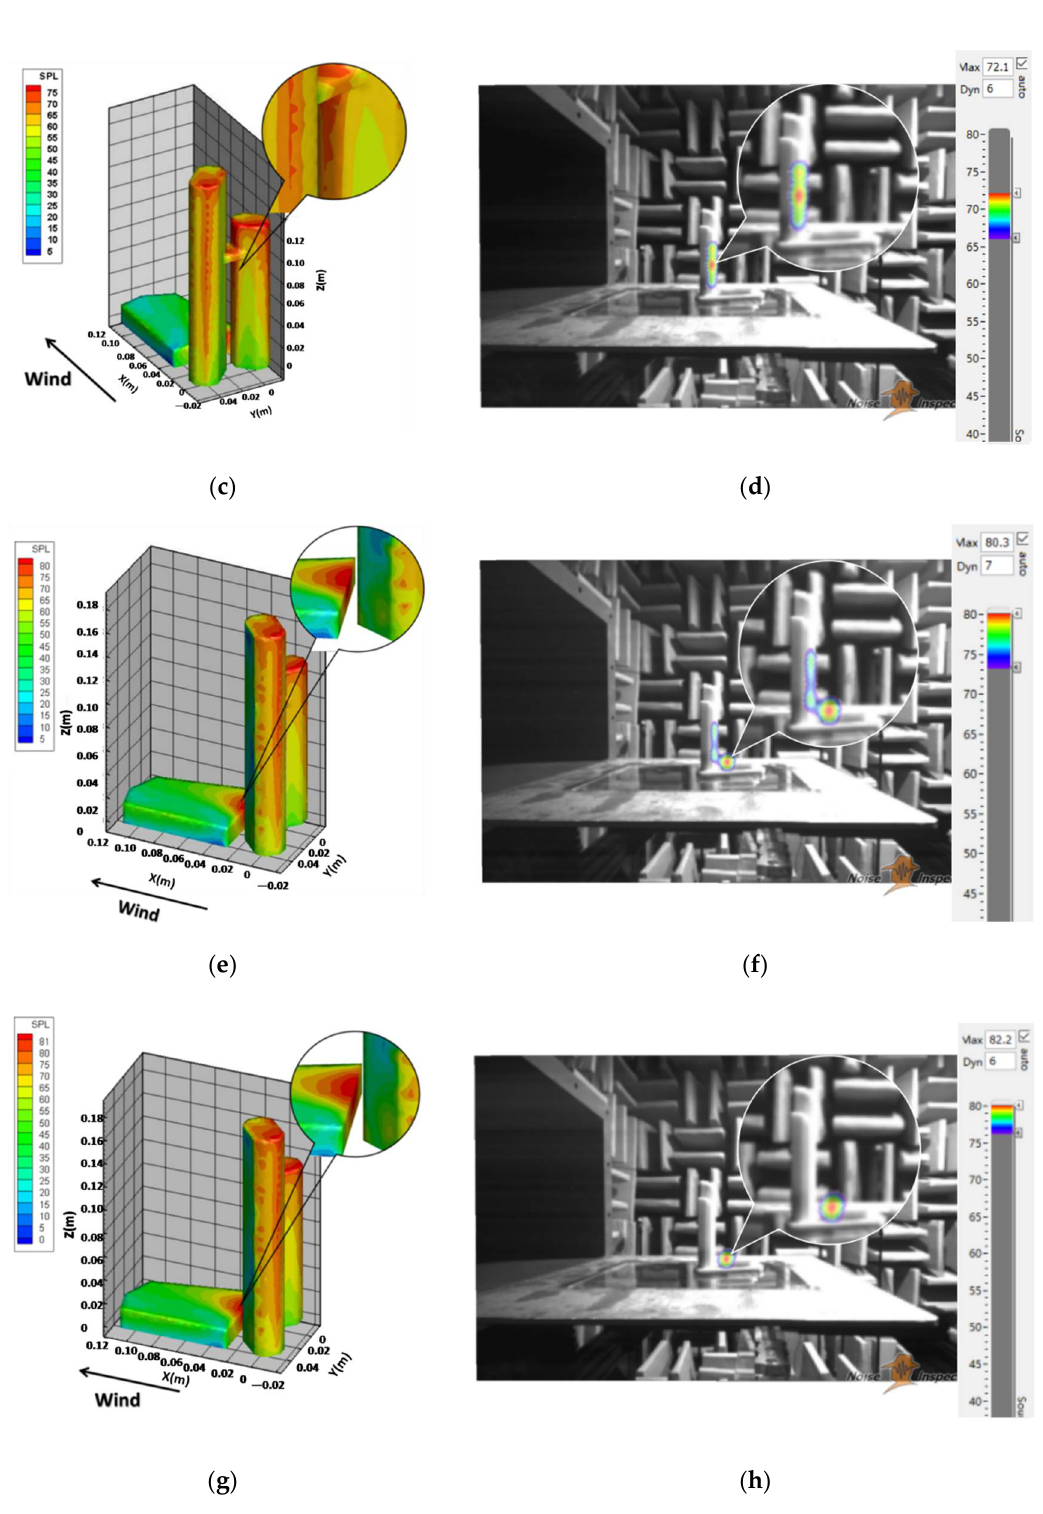
Figure 8. Comparison of experimental and simulated sound source localization at the wind angle of 45°. ( a ) 25 m/s numerical simulation; ( b ) 25 m/s wind tunnel experiment; ( c ) 30 m/s numerical simulation; ( d ) 30 m/s wind tunnel experiment; ( e ) 35 m/s numerical simulation; ( f ) 35 m/s wind tunnel experiment; ( g ) 40 m/s numerical simulation; ( h ) 40 m/s wind tunnel experiment. From Figure 9, it can be seen that the numerically simulated sound source localiza- tion at the wind angle of 90° at each wind speed was consistent with the acoustic wind